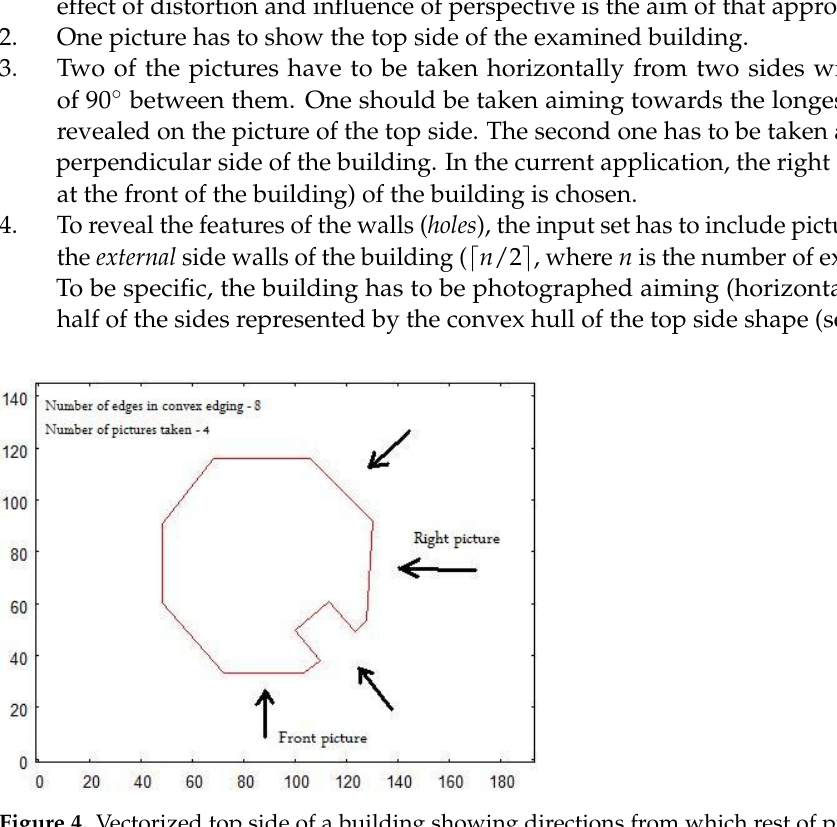
Figure 4. Vectorized top side of a building showing directions from which rest of pictures should be